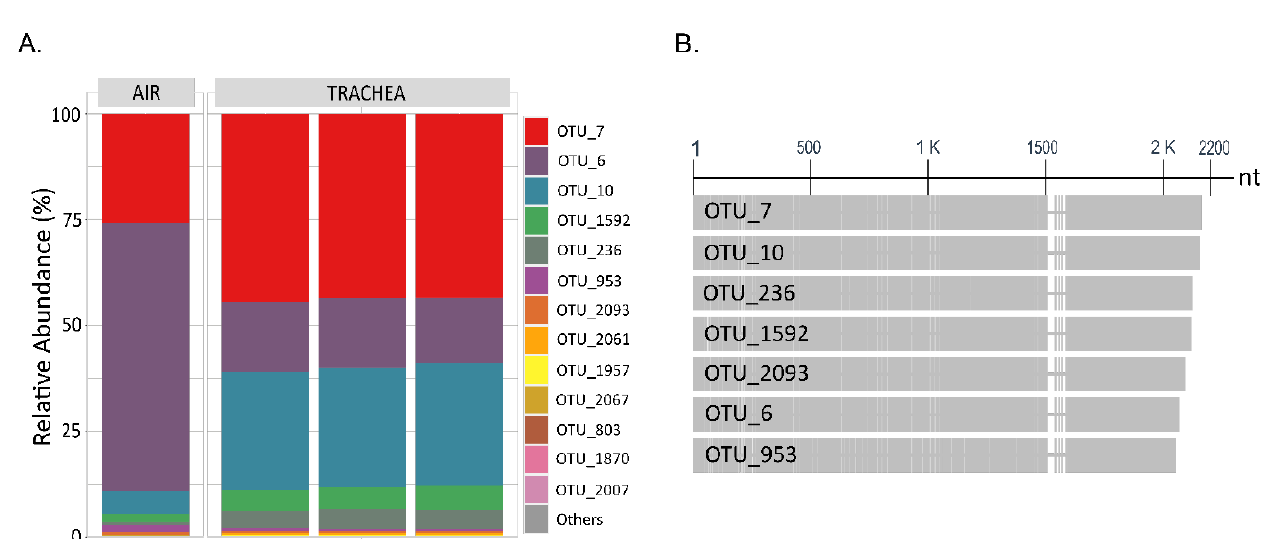
Figure 7. Composition of OPU 437 Escherichia coli/Shigella at the OTU level. ( A ) Stacked bar plot of relative abundances at the OTU level of OPU 437, where OTUs with counts <10 reads were merged into “Others” category. “Air” ( n = 1) and “Trachea” ( n = 3) depict samples in BH-I at week 3 after litter aeration by tumbling. ( B ) Graphical display for the alignments of nucleotide sequences of the 7 most abundant OTUs of OPU 437 in BH-I at week 3, where the ITS region is shown from the 1500 nucleotide (nt) onwards.